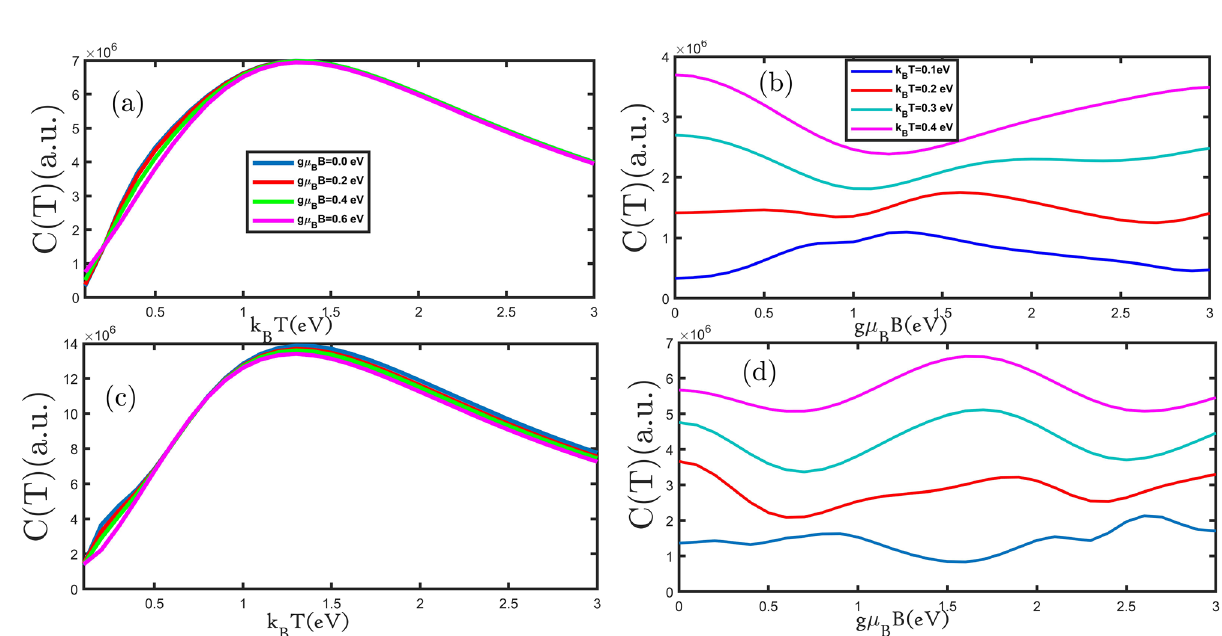
Figure 3. ( a – d ) The electronic heat capacity as a function of the temperature (external magnetic field) for planar and buckled silicene monolayers in the presence of different external magnetic fields (temperatures),